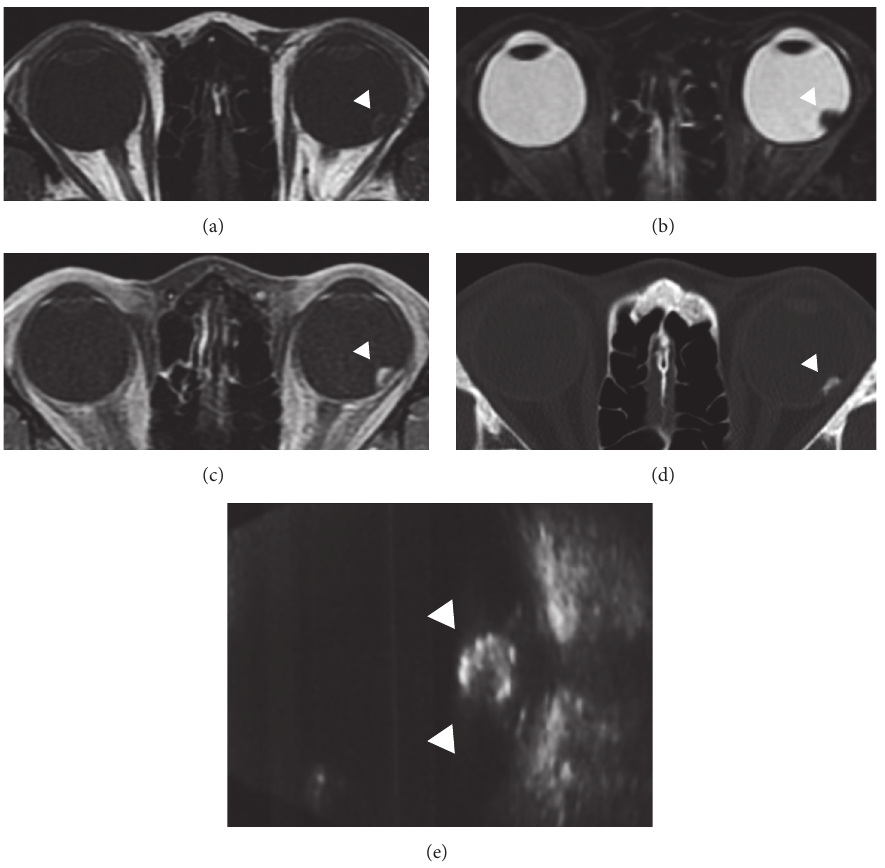
Figure 2: The tumor was depicted as high intensity on both T1-weighted (a) and gadolinium enhanced (c) MRI, low intensity on STIR MRI (b), and high density lesion on CT (d). The B-scan ultrasonography showed high internal reflectivity and acoustic shadowing (e) (arrow heads).